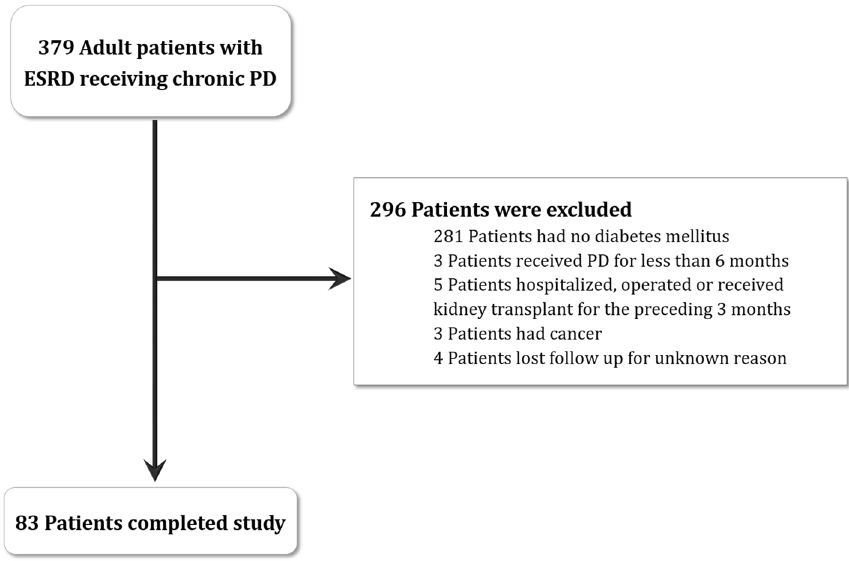
Figure 2. Flow chart. Diagram shows the enrolment and status of patients. ESKD end-stage kidney disease, PD peritoneal